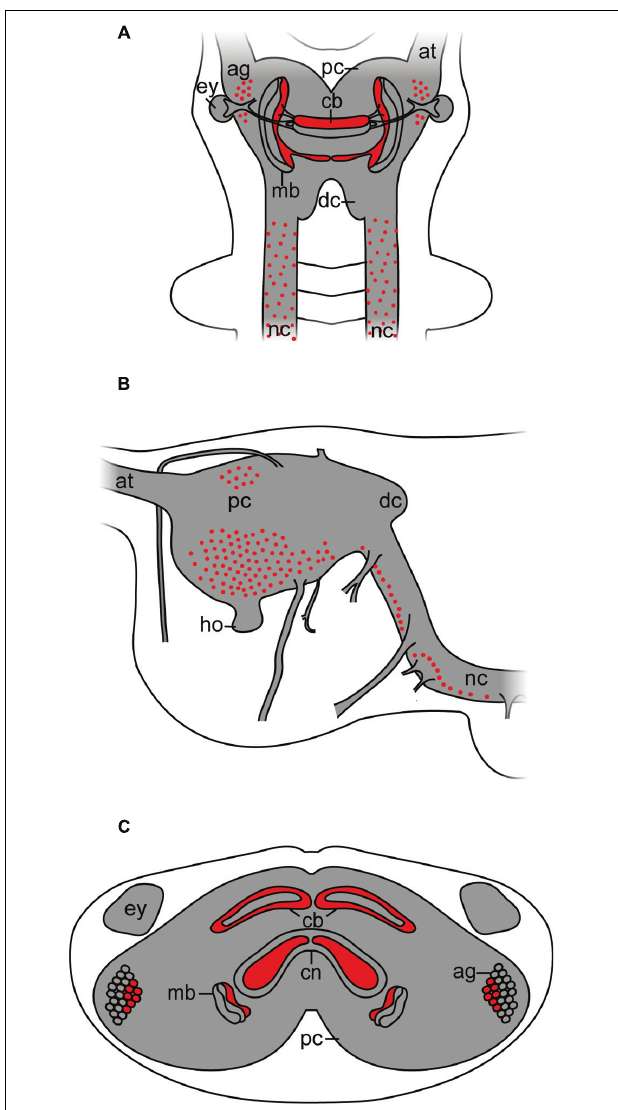
FIGURE 8 | Simplified diagram illustrating the position of Er-arthropsin immunoreactive somata and neuropils in the anterior nervous system of Onychophora. Immunoreactivity within the nerve cord neuropils and the antennal tracts not shown. (A) Dorsal view. Immunoreactive somata and neuropils within the brain are shown. (B) Lateral view. Immunoreactive somata within the brain are shown. Immunoreactive neuropils are not shown. (C) Transverse view (based on cross sections of the head). Immunoreactive neuropils within the brain and immunoreactive somata within the antennal glomeruli are shown. Abbreviations: ag, antennal glomeruli; at, antennal tract; cb, central body; cn, central neuropil; dc, deutocerebrum; ey, eye; ho, hyprocerebral organ; mb, mushroom body; nc, nerve cord; pc,